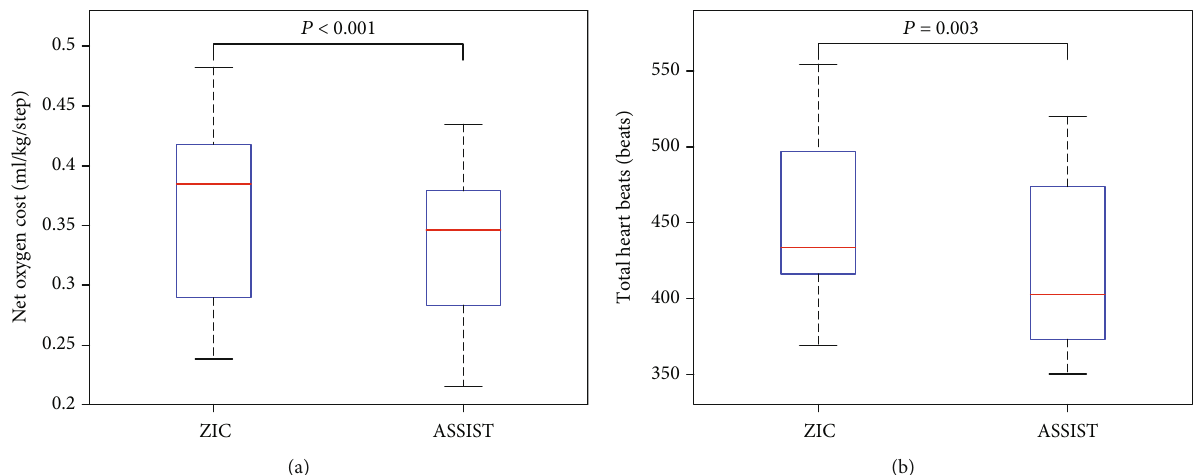
Figure 5: Stair-climbing net oxygen cost (NOC) and total heart beats (THB). NOC (a) and THB (b) were calculated for a 9-level stair climb with (ASSIST) and without climbing assistance (ZIC).